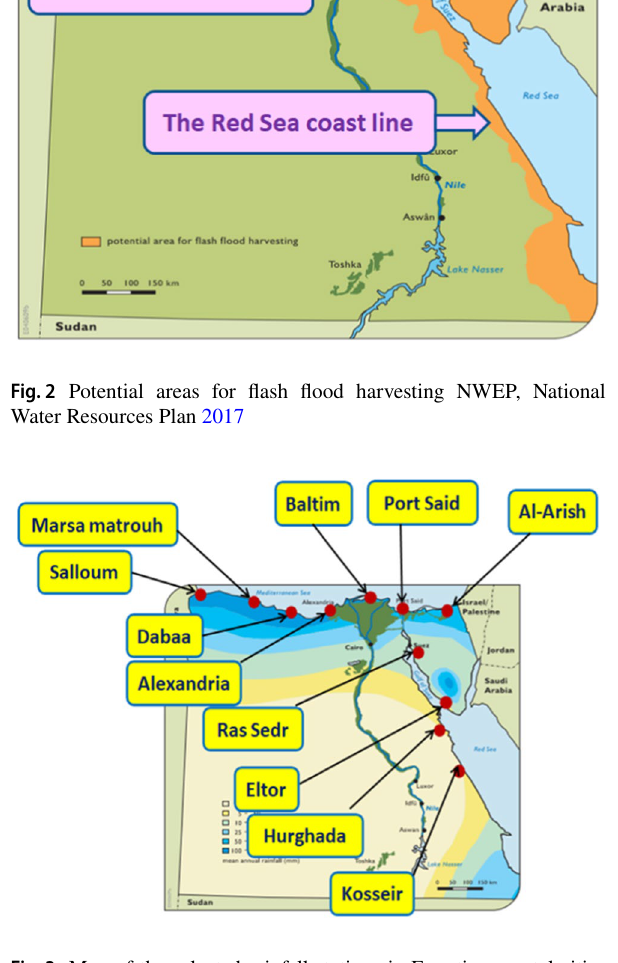
Fig. 3 Map of the selected rainfall stations in Egyptian coastal